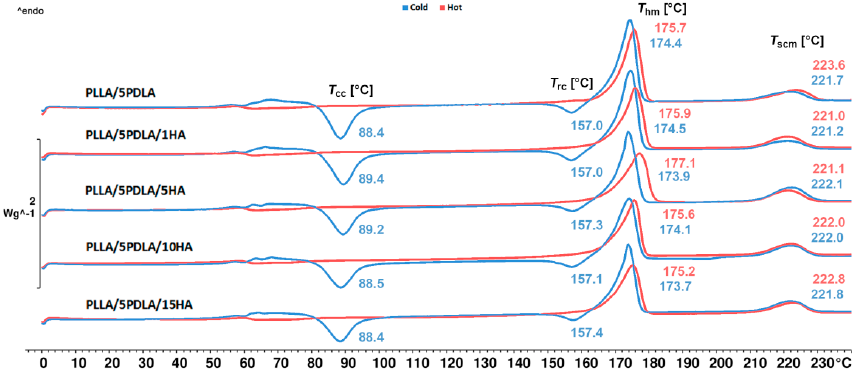
Figure 2. DSC curves of the asymmetric PLLA/5PDLA a PLLA/5PDLA/HA nanocomposites ob- tained during the first heating.